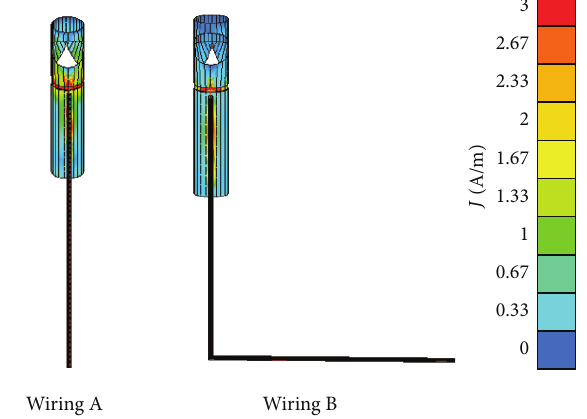
Figure 9: Current distributions on antenna and coaxial cable.